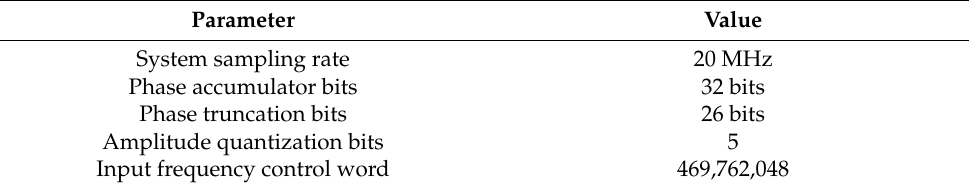
Table 3. Parameter of direct digital synthesizer.